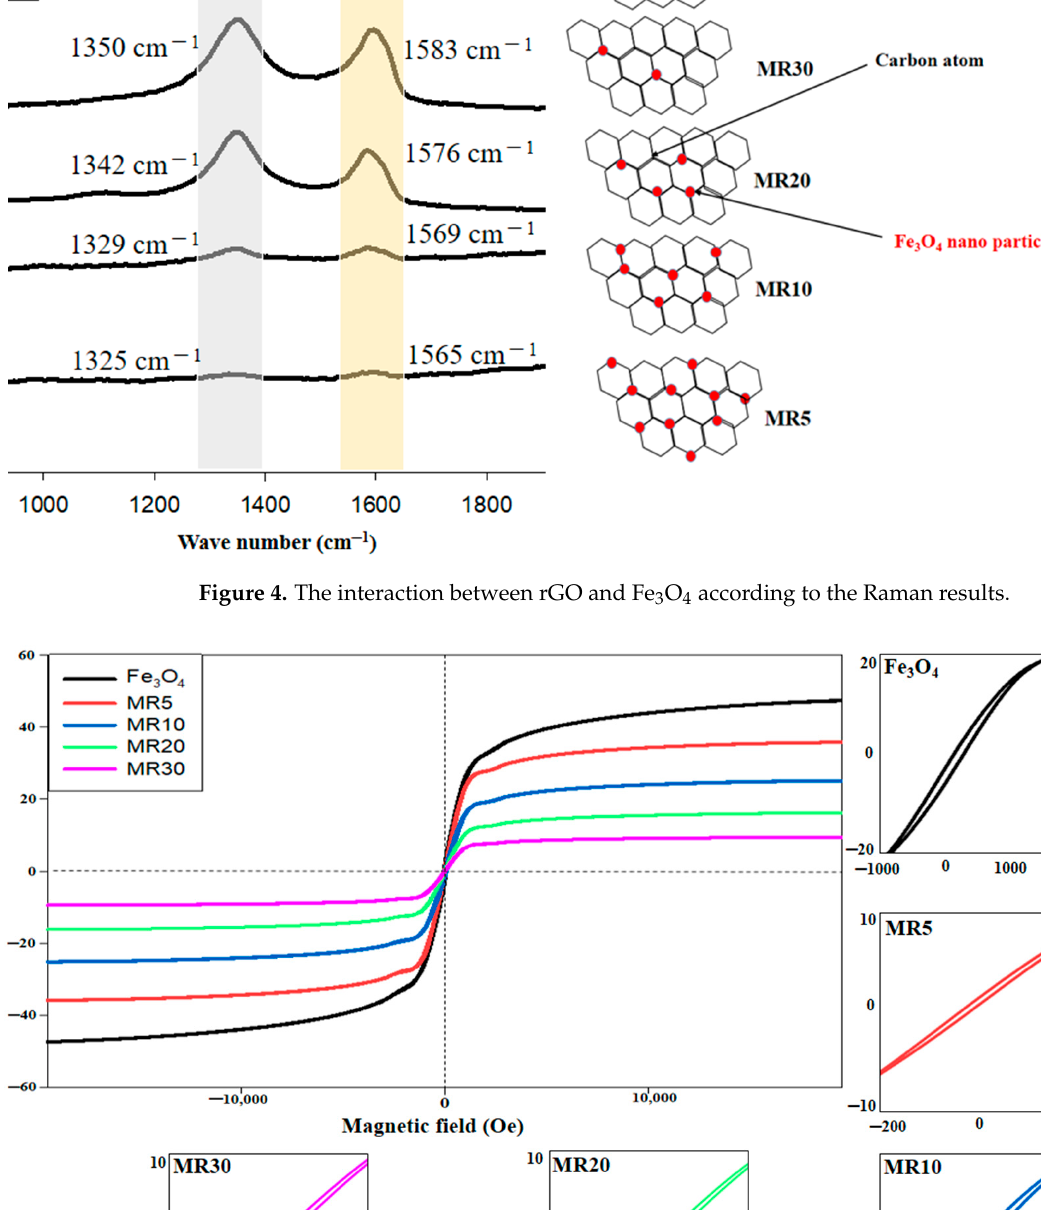
Table 3. A summary of the magnetic properties of the Fe 3 O 4 and Fe 3 O 4 @RGO composites.